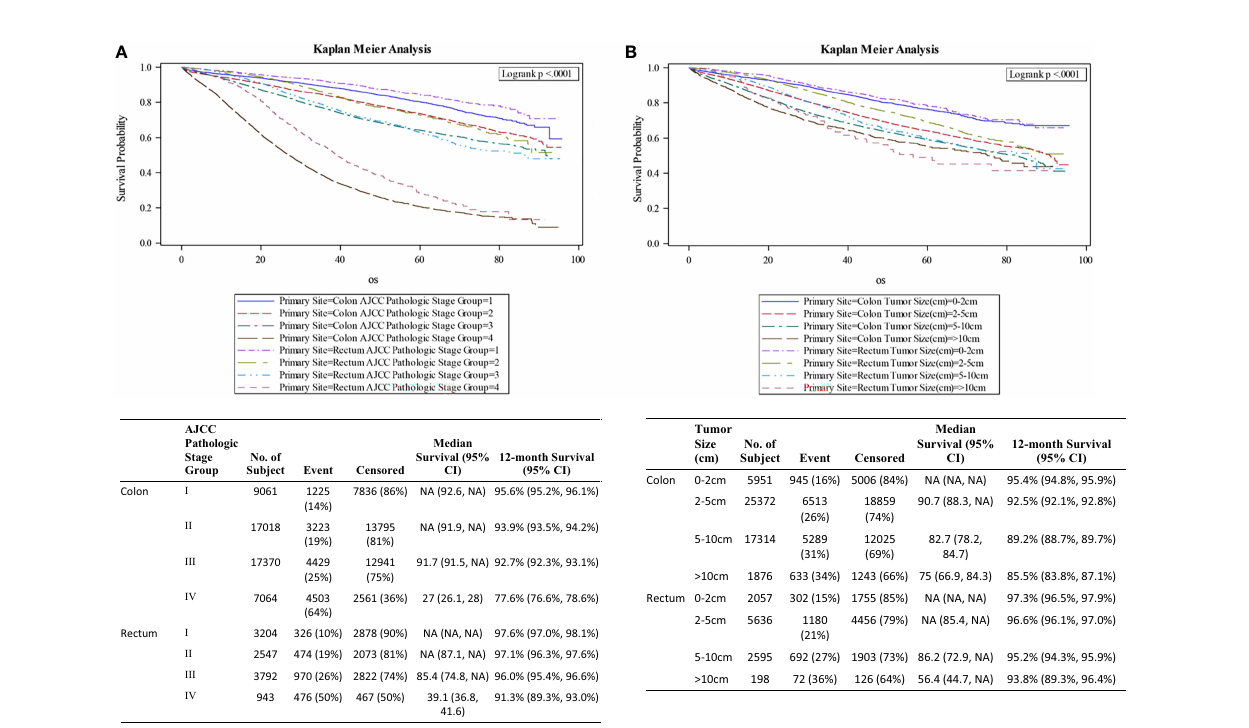
FIGURE 1 | (A) Survival curves by stage. (B) Survival curves by tumor